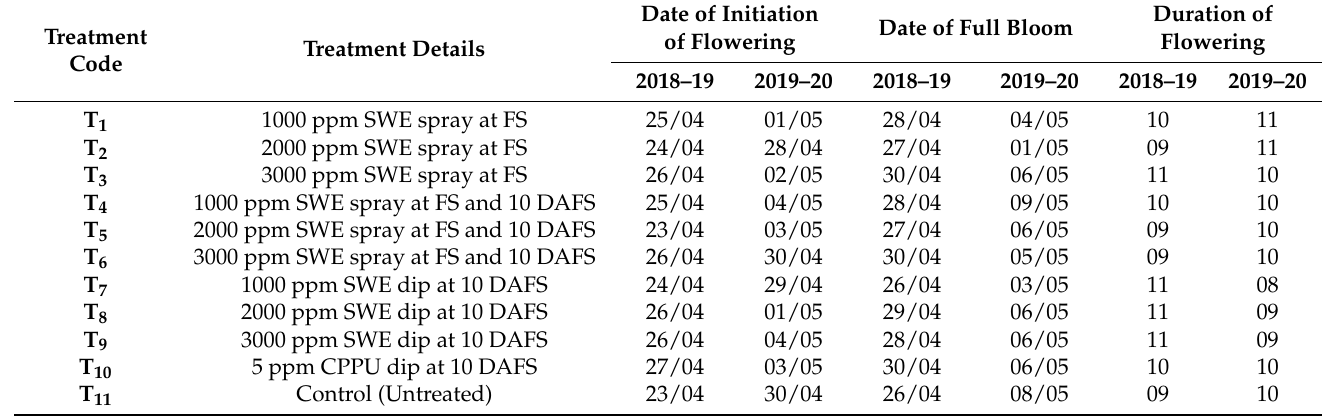
Table 1. Phenological data of